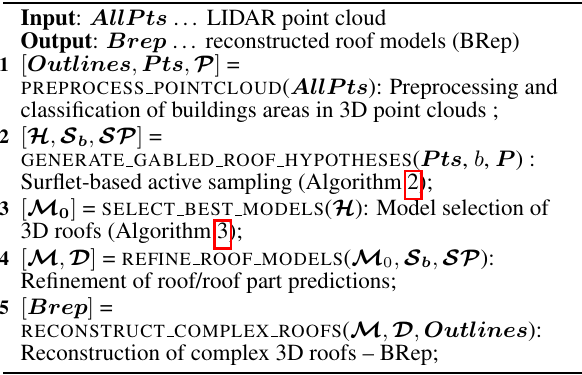
Algorithm 1: Detection and reconstruction of complex building scenes from point clouds – RECONSTRUCT